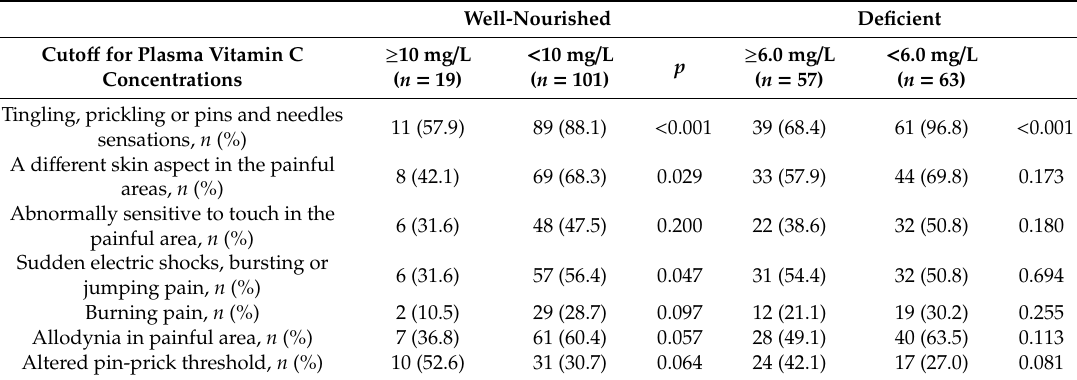
Table 4. The proportions of positive items in the LANSS questionnaire among patients with vitamin C concentrations ≥ the cuto ff value vs. < the cuto ff value.